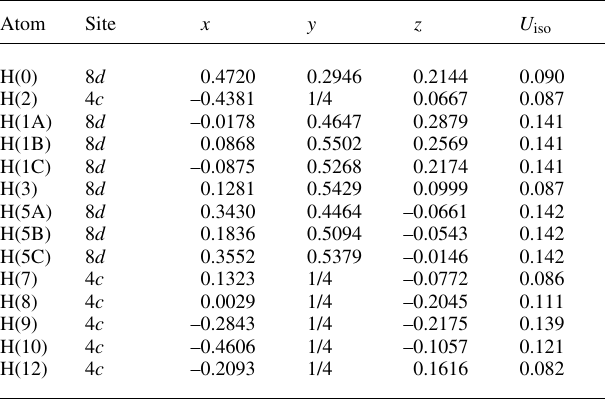
Table 2. Atomic coordinates and displacement parameters (in Å 2 )